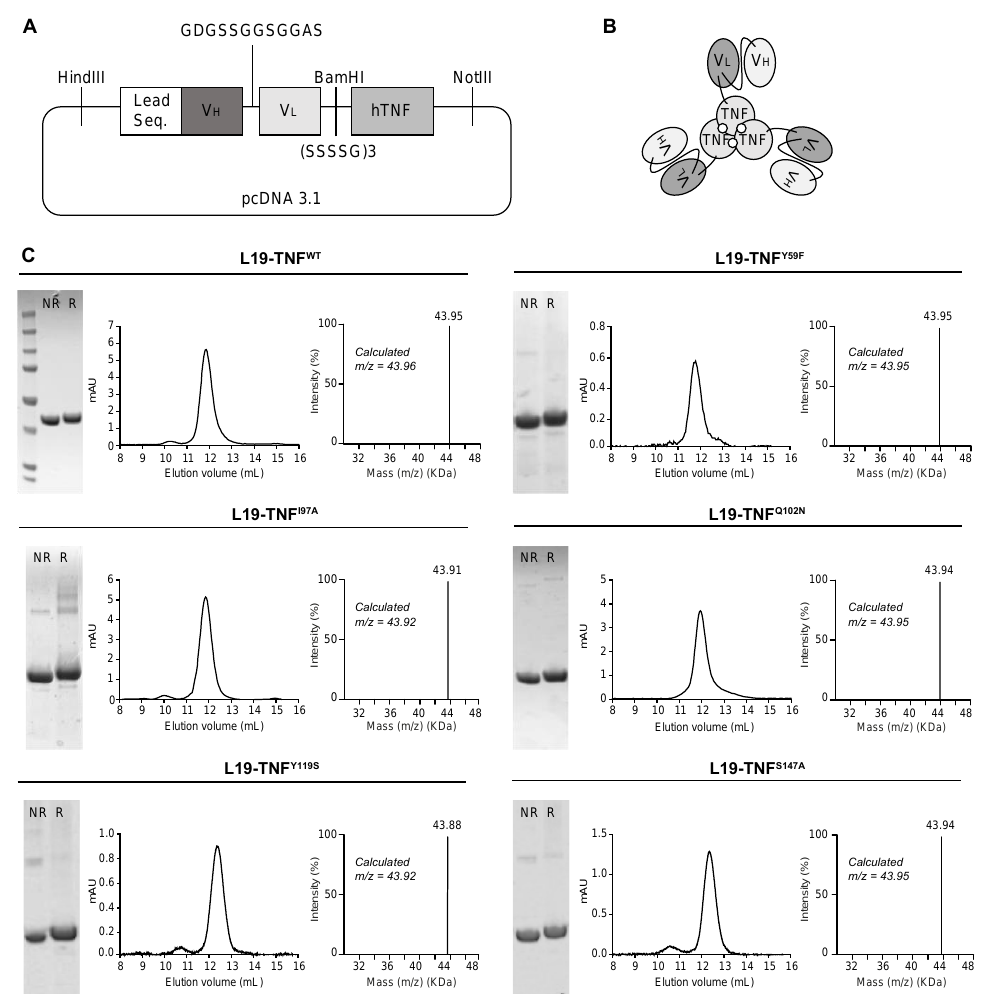
Figure 2. Cloning, expression and quality control analyses of L19-TNF mutants. ( A ) Schematic representation of L19- TNF WT vector used as a template for the generation of mutants. Leader sequence: MGWSLILLFLVAVATGVHS ( B ) General scheme of L19-TNF mutants. ( C ) Quality control of L19-TNF WT and of L19-TNF Y59F , L19-TNF I97A , L19-TNF Q102N , L19- TNF Y119S , L19-TNF S147A mutants by SDS-PAGE, Size Exclusion Chromatography (pic eluting at 12 mL corresponding to the homotrimer form) and LC/MS analyses. NR = non reducing conditions, R = reducing conditions.